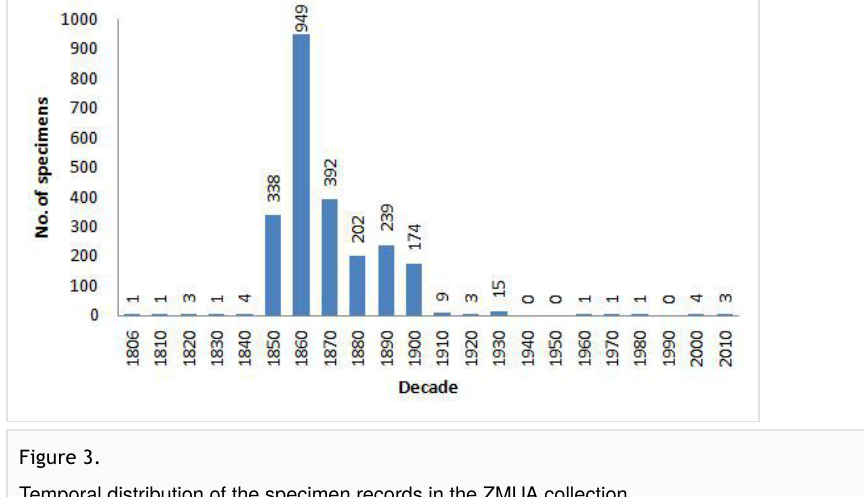
Temporal distribution of the specimen records in the ZMUA